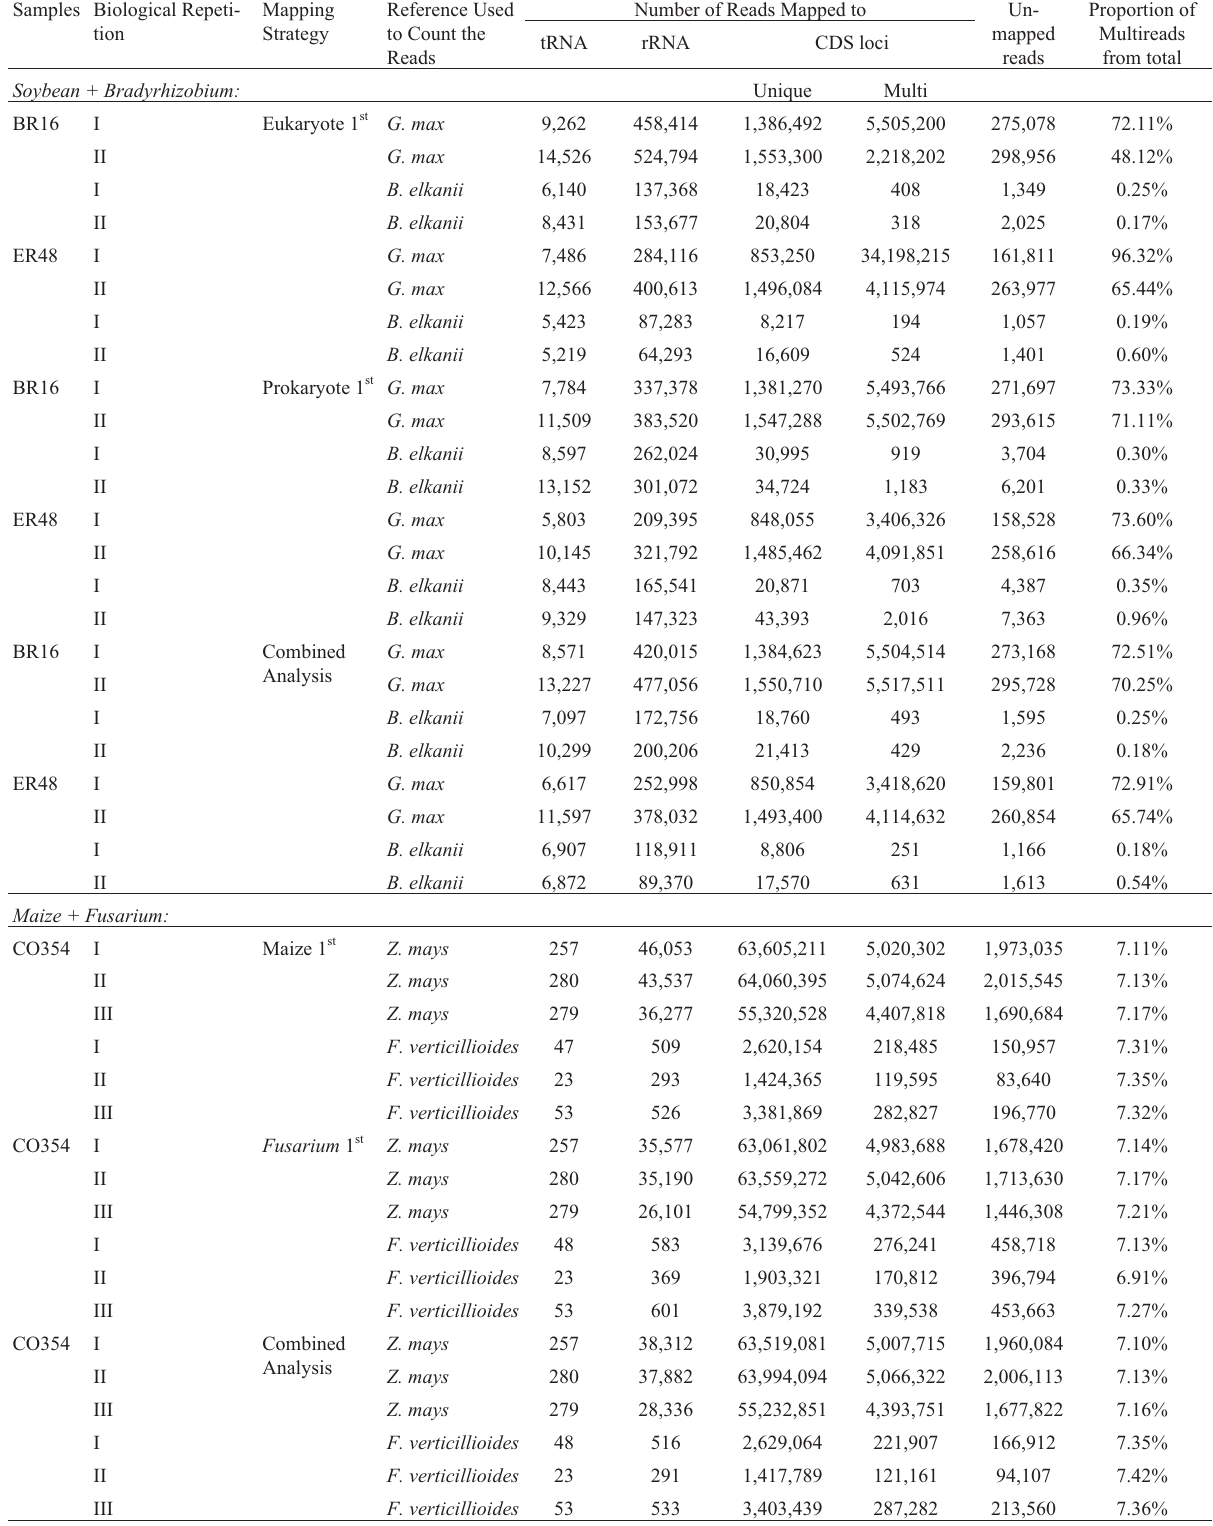
Table4 -NumberofreadsmappedtotRNA,rRNA,andcodingloci(CDS)accordingtothemappingmethodology,withthemappingparametersof0.8of minimum length fraction and 0.8 of minimum similarity fraction, and experiment used. BR16 and ER48: soybean varieties BR16 and Embrapa 48,